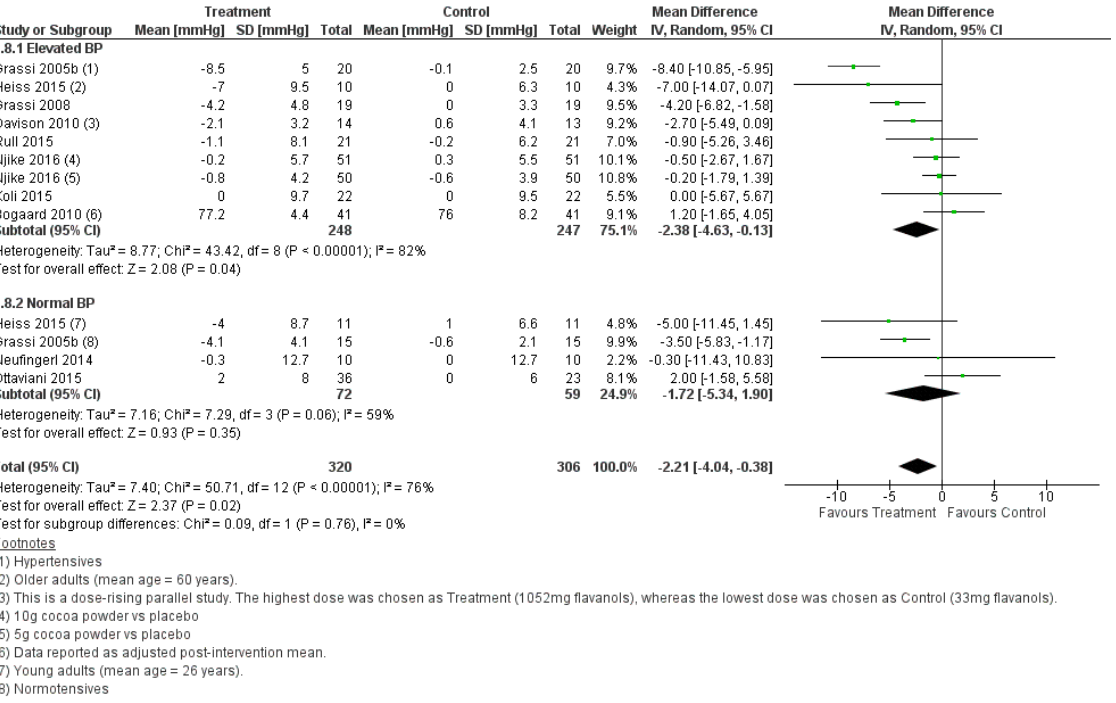
Figure 7. Forest plot showing the pooled effect of cocoa consumption on 24-h diastolic BP.